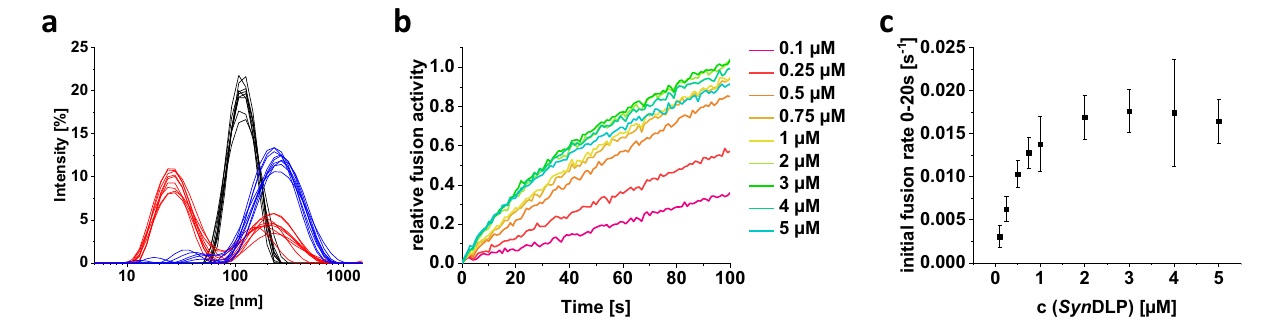
fl uorescenceoverthe fi rst100saftermixing LUVswithprotein.Therelativefusion activities were calculated as described in the methods section. The curves repre- sent the mean of three independent measurements. The whole measurement as well as the positive control containing 2 µ M of the fusogenic protein IM30 are shown in Supplementary Fig. 18. c Initial fusion rates (black) were calculated from thecurvesin( b )de fi nedastheslopeofalinearregressionofthe fi rst20s.Meanof independent measurements ( n =3) and error bars (S.D.) are